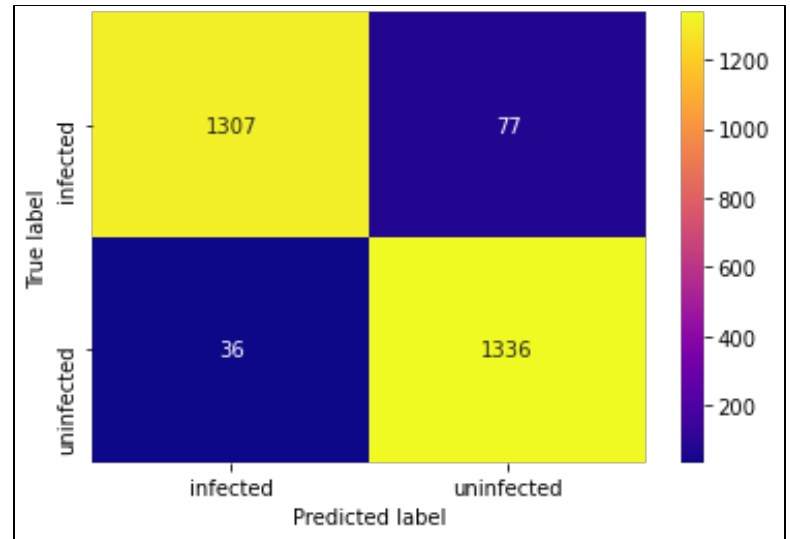
Table 1. Convolutional neural Network model summary.